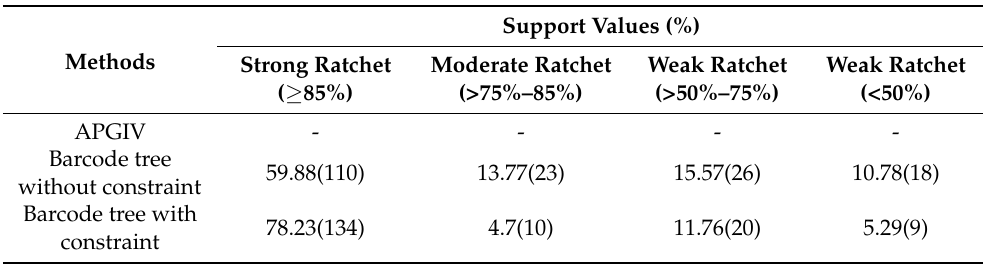
Table 1. Statistical results of ratchet support values for all nodes of each phylogenetic tree constructed with DNA sequence data.